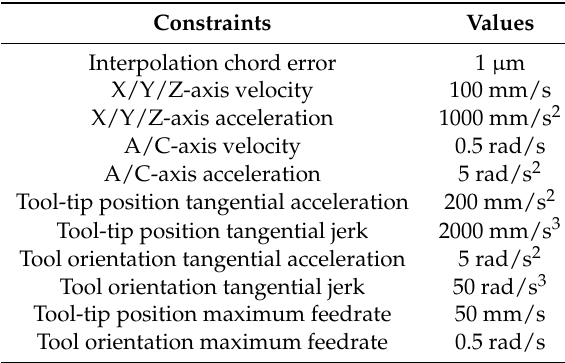
Figure 7. Configuration of experimental five-axis computer numerical control (CNC) machine tool— ( a ) Real product. ( b ) Layout. Table 1. Predefined constraints in the